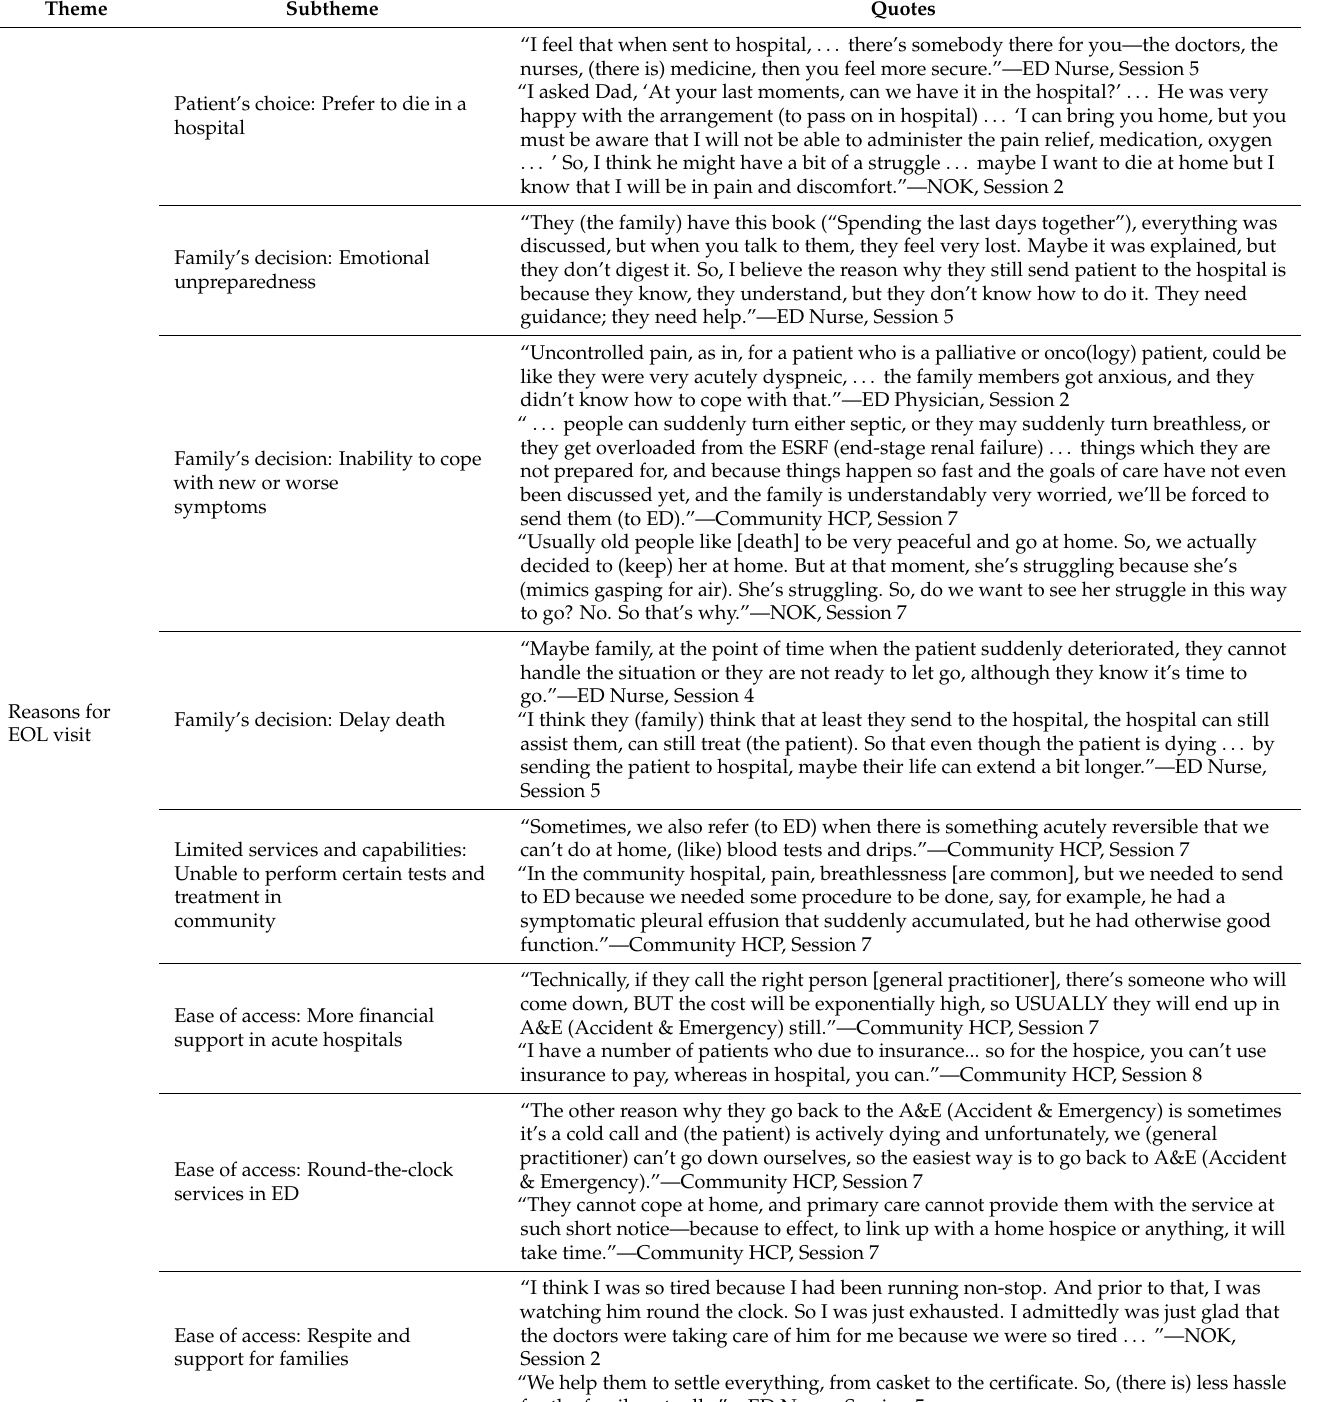
Table A1. Additional quotes from participants for identified